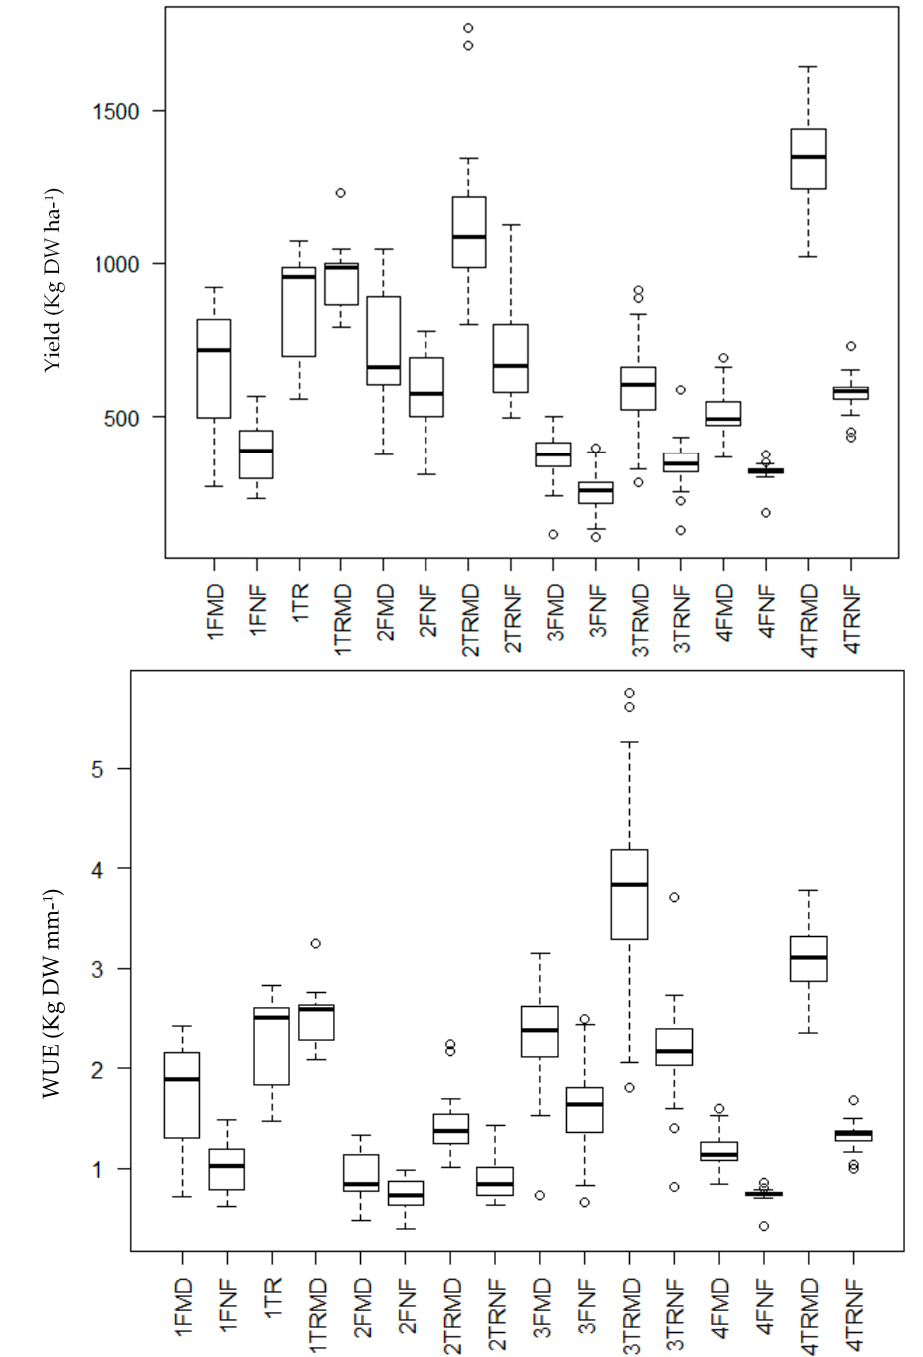
Figure 7. The intra- and inter-seasonal average pearl millet yields under different treatments and planting windows across four cropping seasons. The treatments (X-axis) are FNF, which denotes flat cultivation without microdosing; FMD, which denotes flat cultivation with microdosing; TRNF, which denotes tied ridge cultivation without microdosing; and TRMD, which denotes tied ridge cultivation with microdosing).